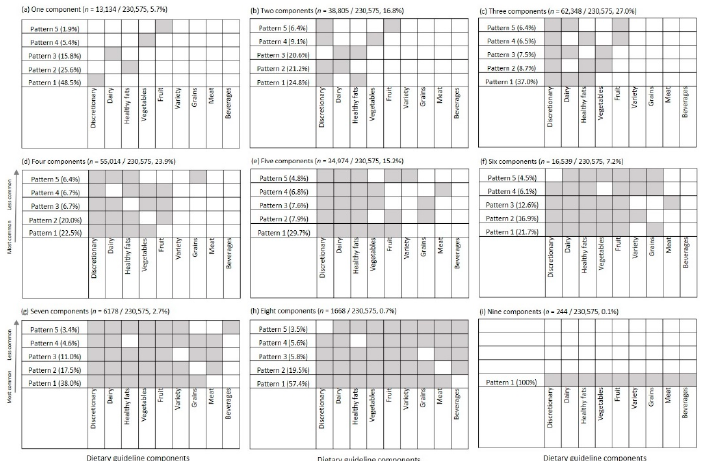
Figure 3. The five most common combinations of diet guideline index components, by total number of low scoring components. Data not shown for individuals with no low scoring components ( n = 1670/230,575, 0.7% of the sample).